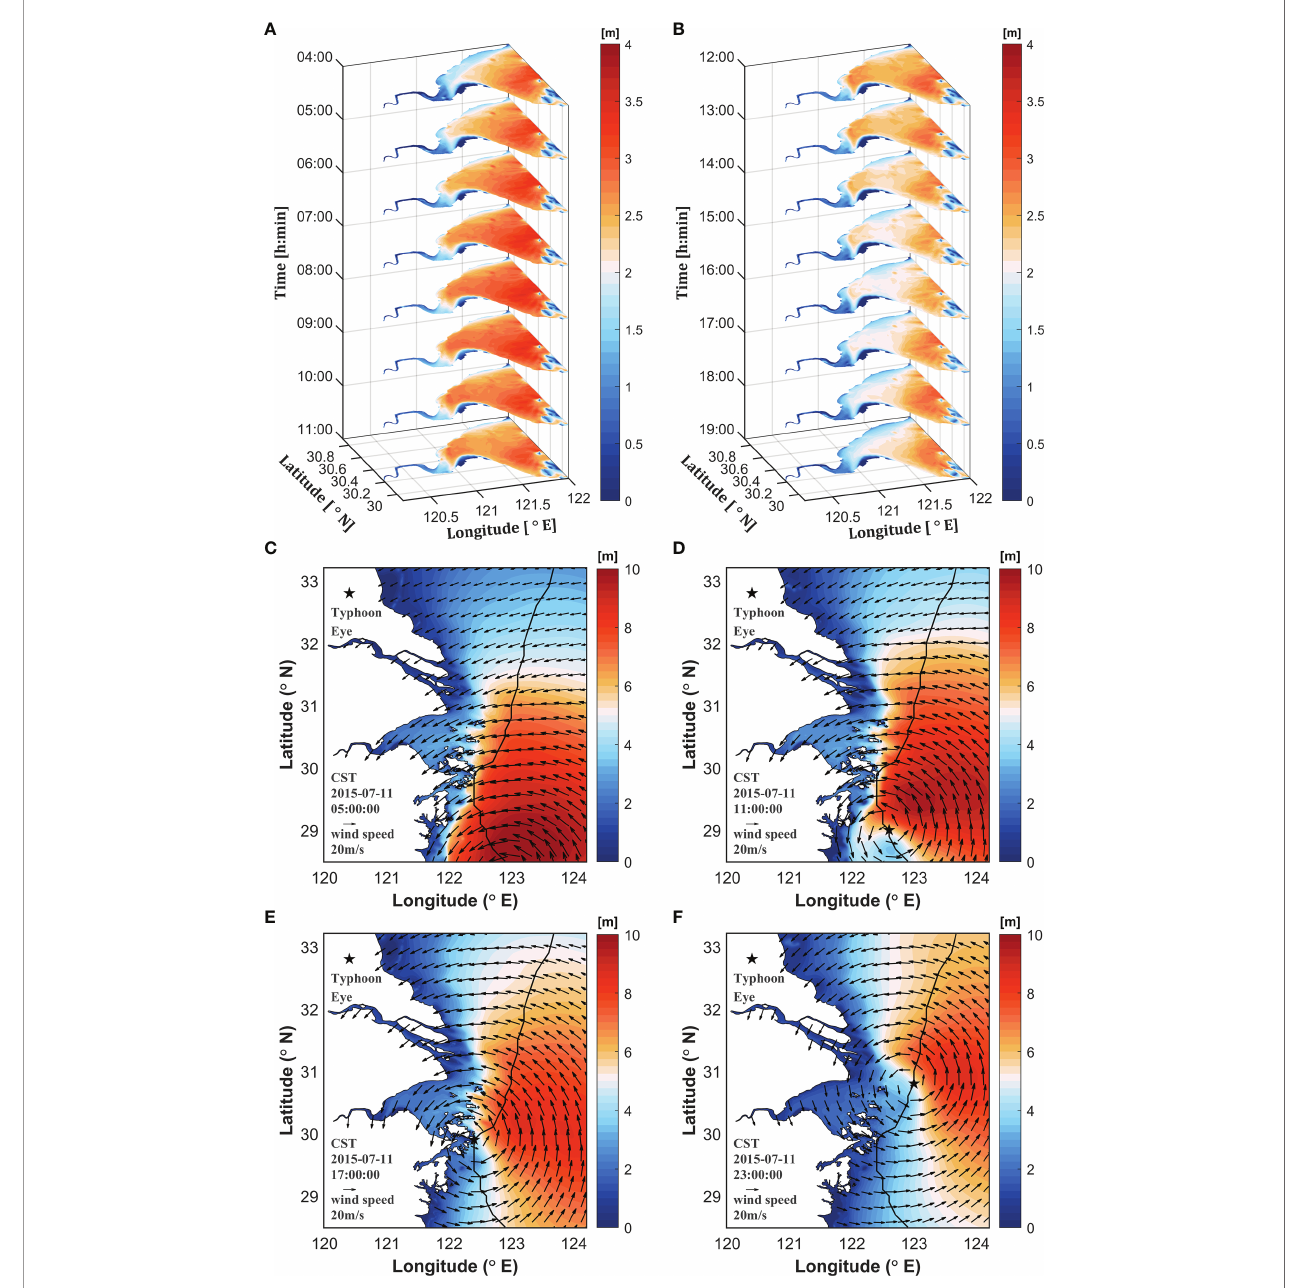
FIGURE 6 | Signi fi cant wave heights inside the bay at: (A) 04:00 to 11:00 (B) 12:00 to 19:00 on July 11. Signi fi cant wave heights at (C) 05:00, (D) 11:00, (E) 17:00 and (F) 23:00 on July